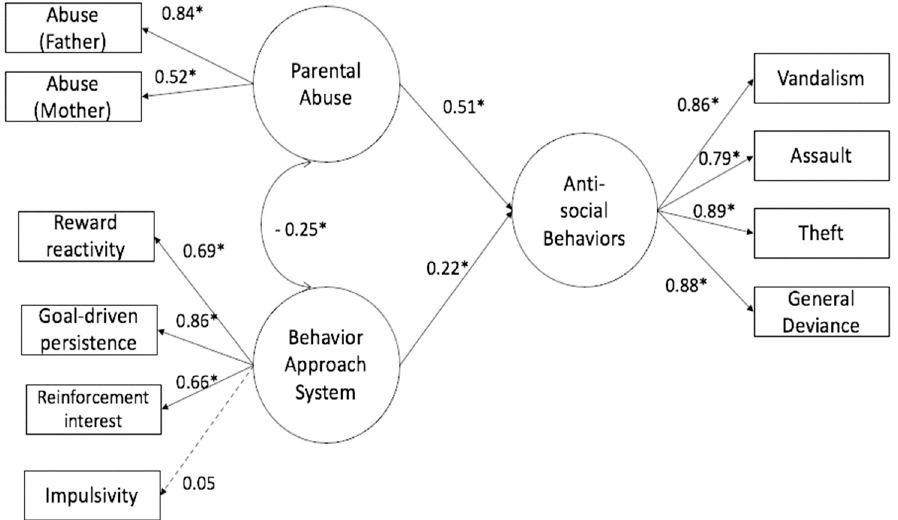
Figure 1. Structural model of child abuse and the behavior approach system and its influence on adolescent antisocial behavior. Mardia = 285.11, SBX2 (32 D.F.) = 38.27, p = 0.20, BBNNFI = 0.96; CFI = 0.97; RMSEA = 0.02, R2 = 0.37 * p < 0.05.